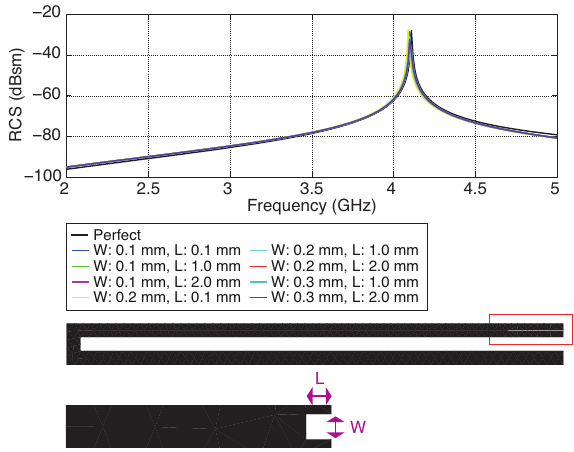
Figure 10: Electromagnetic response of a single resonator when there is crack on the tip of an arm.